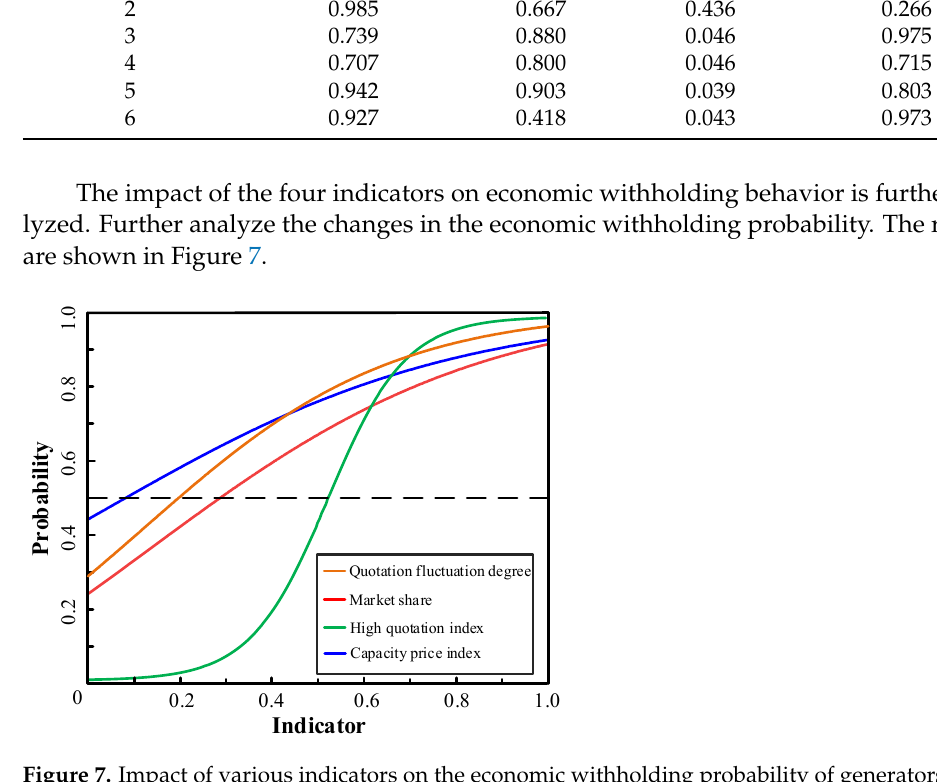
Figure 7. Impact of various indicators on the economic withholding probability of generators.